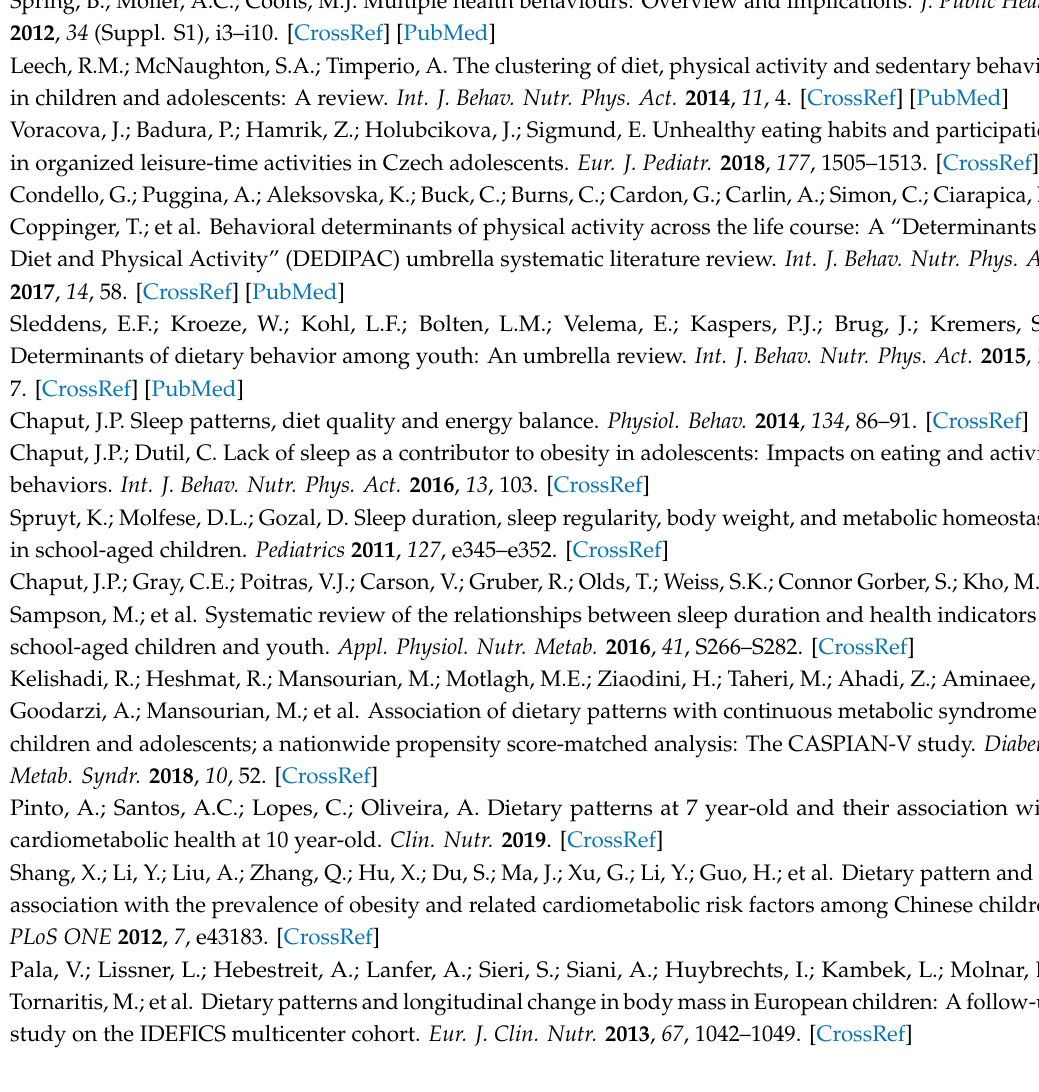
Figure S1: Flowchart for participant selection, Table S1: P interaction for sex and unhealthy factors with changes in cardiometabolic risk factors, Table S2: P interaction for intervention and unhealthy factors with changes in cardiometabolic risk factors, Table S3: Characteristics by a combination of three unhealthy factors, Table S4: Combination of three healthy factors and changes in cardiometabolic risk factors in children, Table S5: Change in the number of unhealthy factors and changes in cardiometabolic risk factors in children, and Table S6: Combination of three healthy factors and changes in cardiometabolic risk factors in children in the control